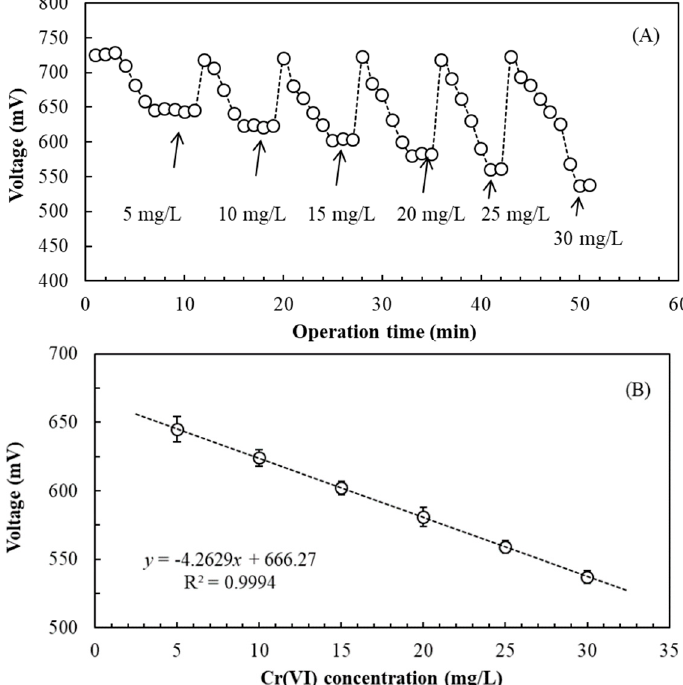
Figure 5. ( A ) Effect of different inlet Cr(VI) concentrations on voltage output of the SCMFC biosensor inoculated with E. aestuarii YC211 in the continuous-flow operation (liquid retention time: 2 min, external resistance: 500 Ω ); ( B ) Relationship between Cr(VI) concentration and voltage output of the SCMFC biosensor inoculated with E. aestuarii YC211 in the continuous-flow operation (voltage data